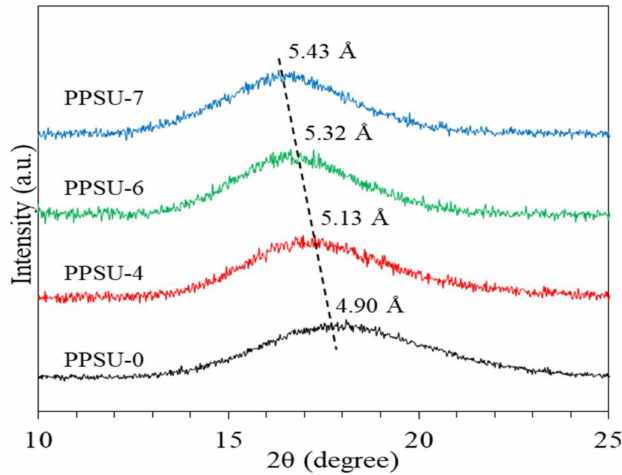
Figure 5. XRD spectra of